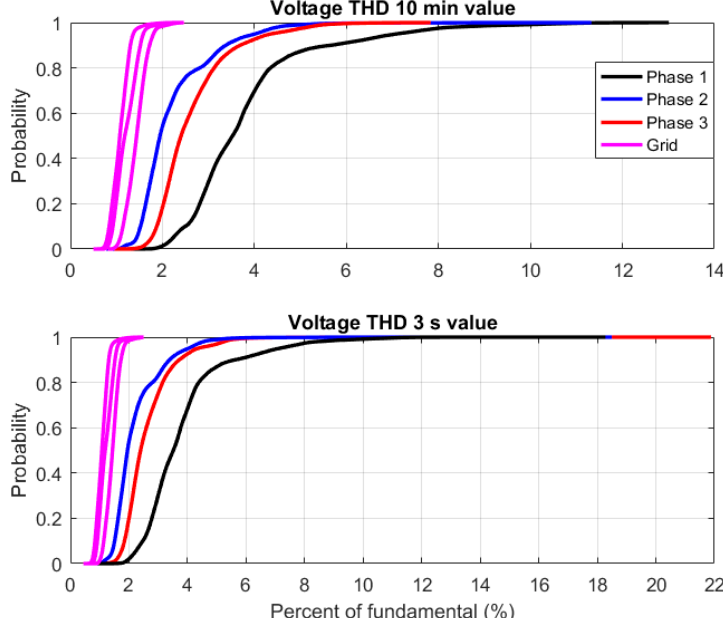
Figure 2. Cumulative distribution function (CDF) for the 10 min voltage Total Harmonic Distortion (THD) for the nanogrid during islanded and grid-connected operation ( top ) and the CDF for the 3 s voltage THD during grid-connected and islanded operation ( bottom ). Note that the horizontal axis is different for each plot. Energies 2018 , 11 , x FOR PEER REVIEW